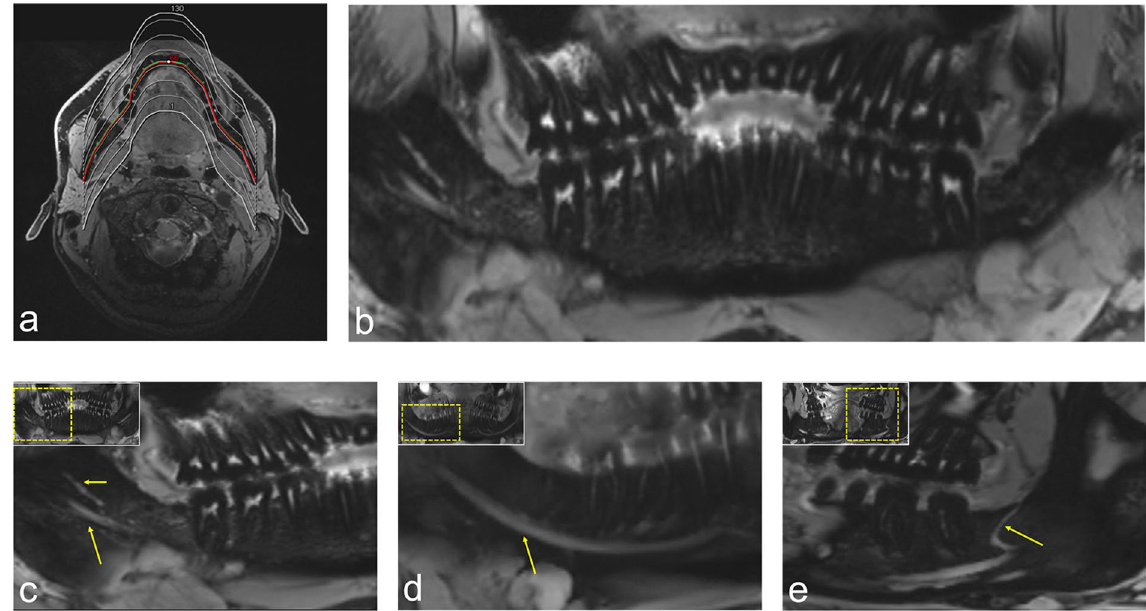
Figure 2. OPG (orthopantomogram) MRI reconstructions (MR-OPG) from a 3D double-echo steady-state (DESS) dataset. T2-w imaging using DESS-MRI (scan time approximately 12 minutes) allows visualization of the complex neural microarchitecture of the thinnest peripheral branches of the mandibular division of the trigeminal nerve. ( a ) MR-OPG with a slice thickness of 0.5 mm were created using the curved multiplanar reconstruction (MPR) function of syngo.via (release VB60a, Siemens Healthineers, Erlangen, Germany). ( b ) Overview image of a DESS MR-OPG. ( c ) Visualization of the fourth quadrant of a study participant’s DESS MR-OPG. The long arrow points to the inferior alveolar nerve (IAN), while the short arrow represents the lingual nerve. ( d ) Visualization of the course of the T2- weighted hyperintense signal of the IAN through the mandible, whereas ( e ) shows a retromolar branch of the